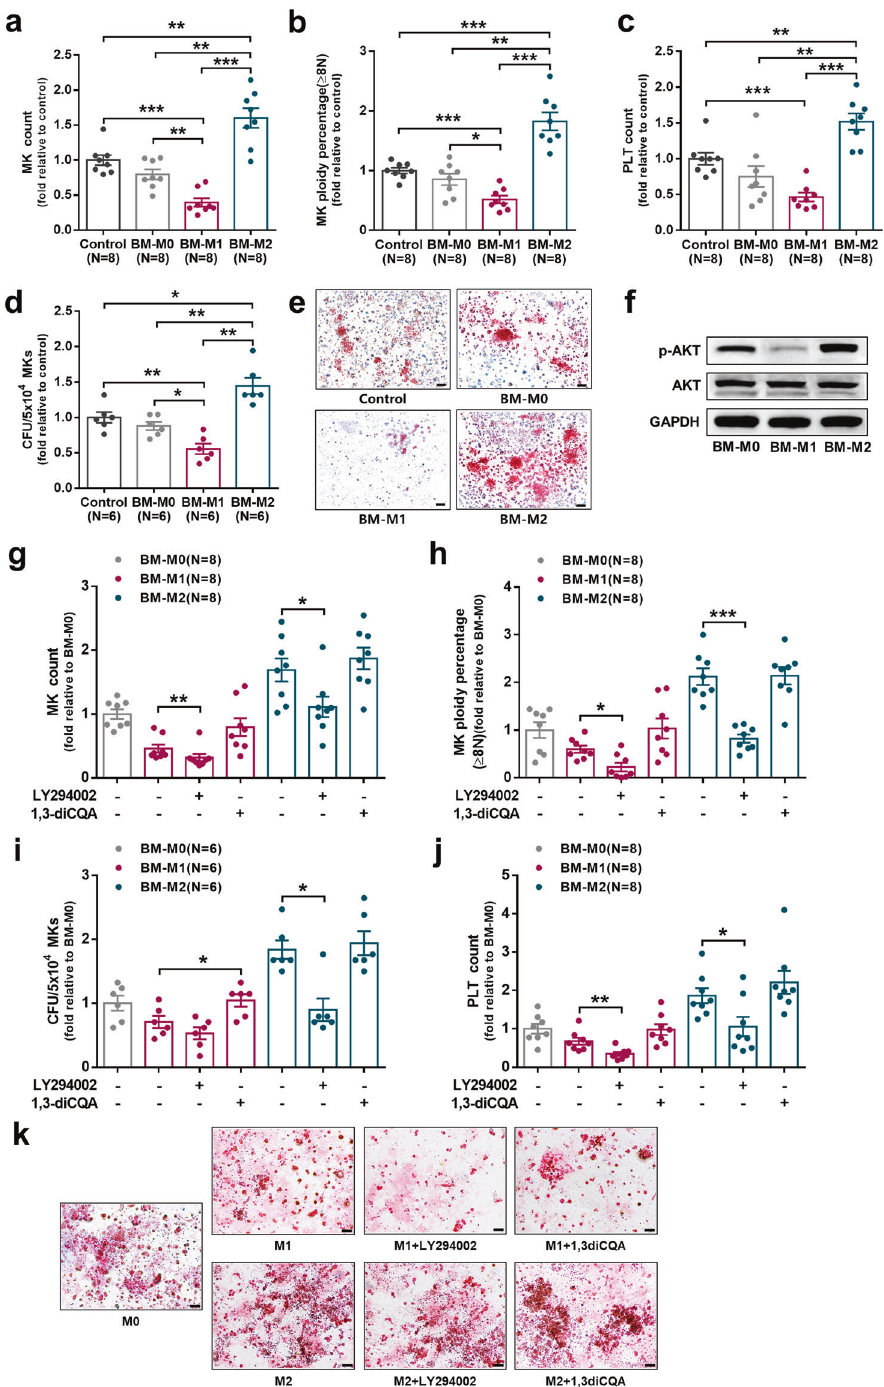
Fig. 4 BM-M1 and BM-M2 exerted opposing effects on megakaryopoiesis and platelet production in vitro. The primary BM-M0 from HD were polarized into BM-M1 or BM-M2. Then, direct-contact coculture experiments of the MKs, which were differentiated from BM CD34 + cells of HD, with BM-M0, BM-M1 or BM-M2 were performed, respectively. The a MK count, b MK ploidy distribution, c platelet count, d CFU-MK count, and e representative CFU-MK images (scale bars represent 50 μ m) were analyzed after 12 days of coculture. f Representative western blots of p-AKT, AKT, and GAPDH in BM-M0, BM-M1, and BM-M2. The M Ф s were treated with chemical inhibitors LY294002 (10 μ M) and activators 1,3- dicaffeoylquinic acid (1,3-diCQA) (10 μ M) and the control group was treated with DMSO. The CD34 + cells were direct- contact cocultured with the treated M Ф s. The g MK count, h MK ploidy distribution, i CFU-MK count, j platelet count and k representative CFU-MK images (scale bars represent 50 μ m) were analyzed after 12 days of coculture. Data are presented as the means ± SEM (* P ≤ 0.05, ** P ≤ 0.01, *** P ≤